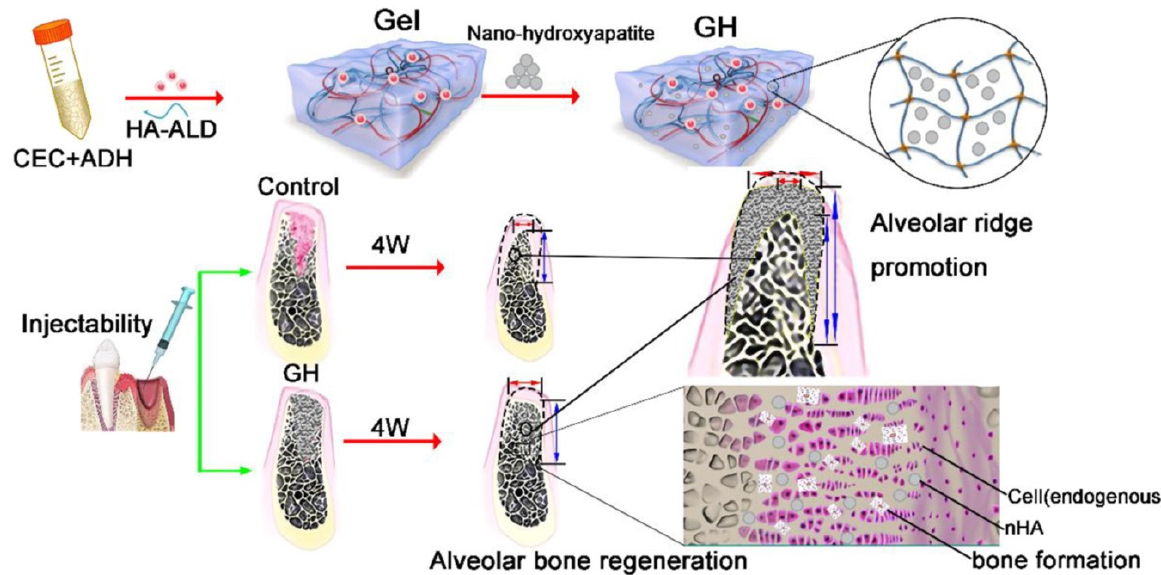
Figure 4. Illustration of the fabrication process of a polysaccharide hydrogel–hydroxyapatite scaffold (GH), which transports the composite to the incisor rat extraction for the investigation of aesthetic alveolar ridge preservation. The alveolar bone deficiency model was created by removing the rat mandibular central incisor, followed by minimally invasive scaffolding into the extraction site. Copyright Elsevier 2020 [121].